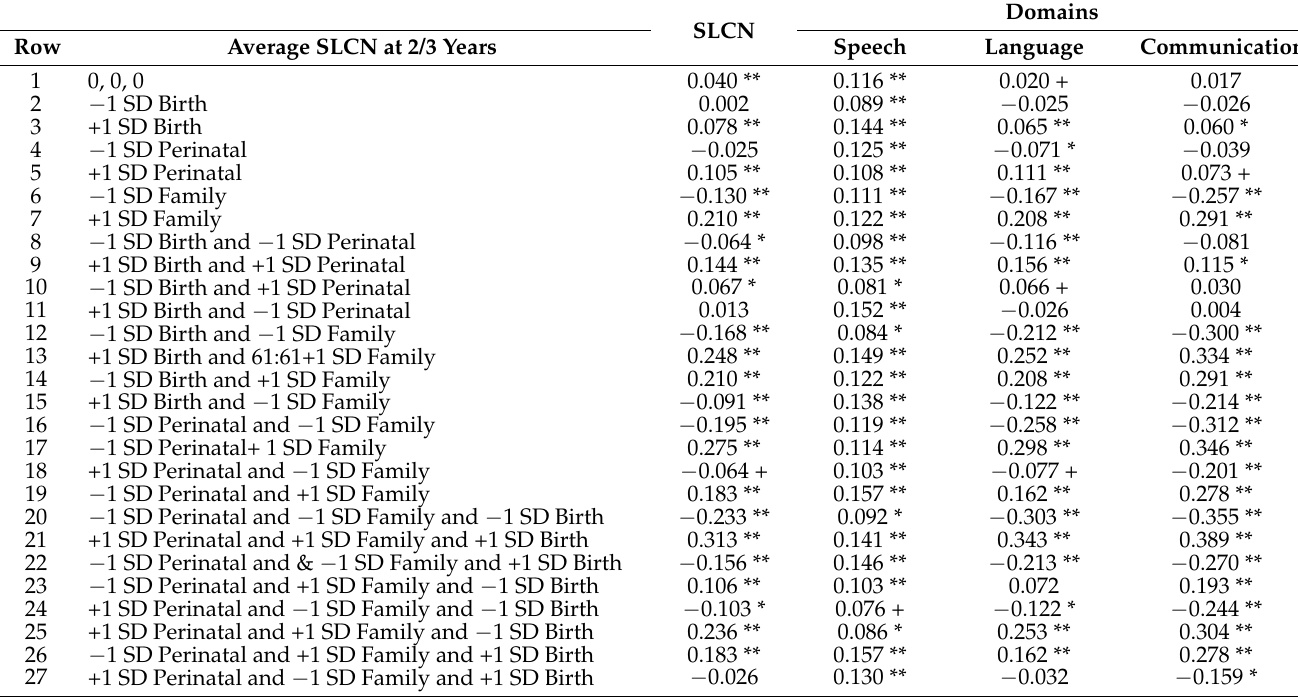
Table 5. SLCN algorithm at 2 to 3 years. SLCN